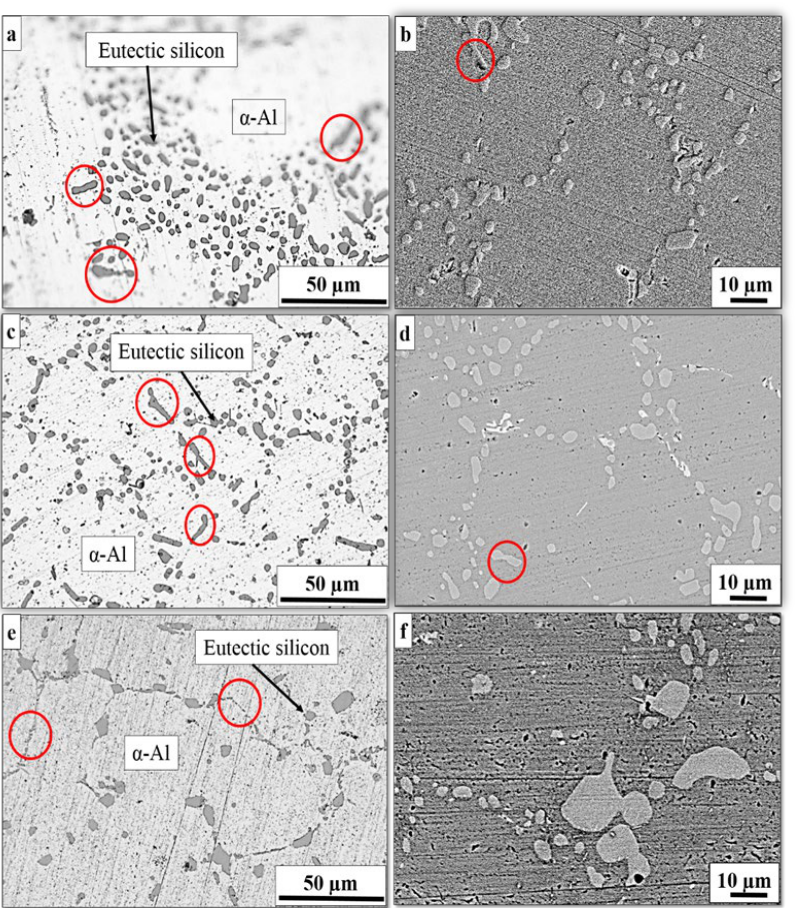
Figure 4. Optical and SEM micrographs of heat-treated eutectic Si particles in ( a,b ) as-cast, ( c,d ) cooling slope and ( e,f ) thixoformed Al–7Si alloy samples.